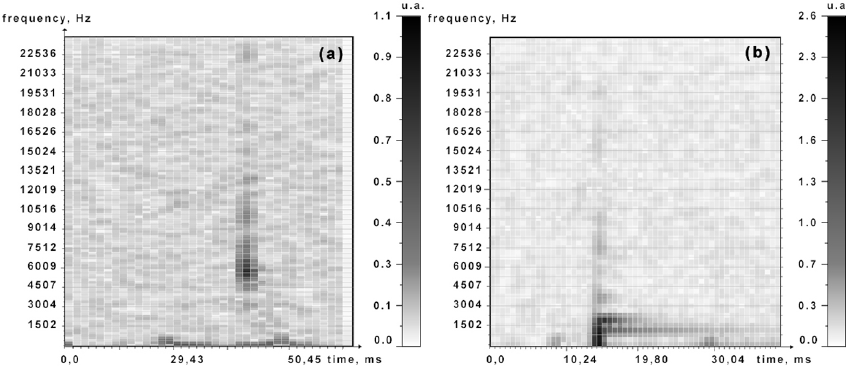
Figure 9. EM signals registered during rubbing of the (a) granite and the (b) granodiorite